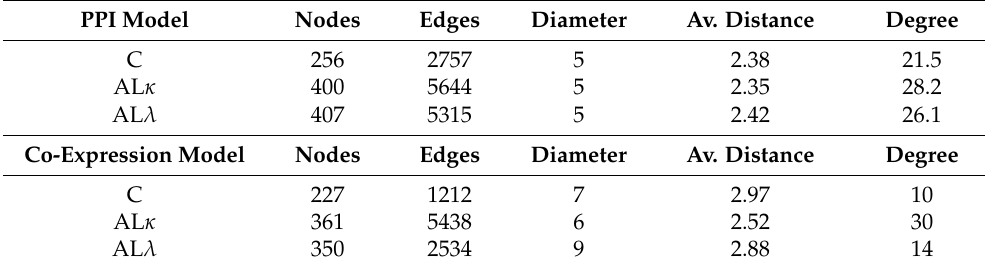
Table 1. Network centralities from PPI and co-expression